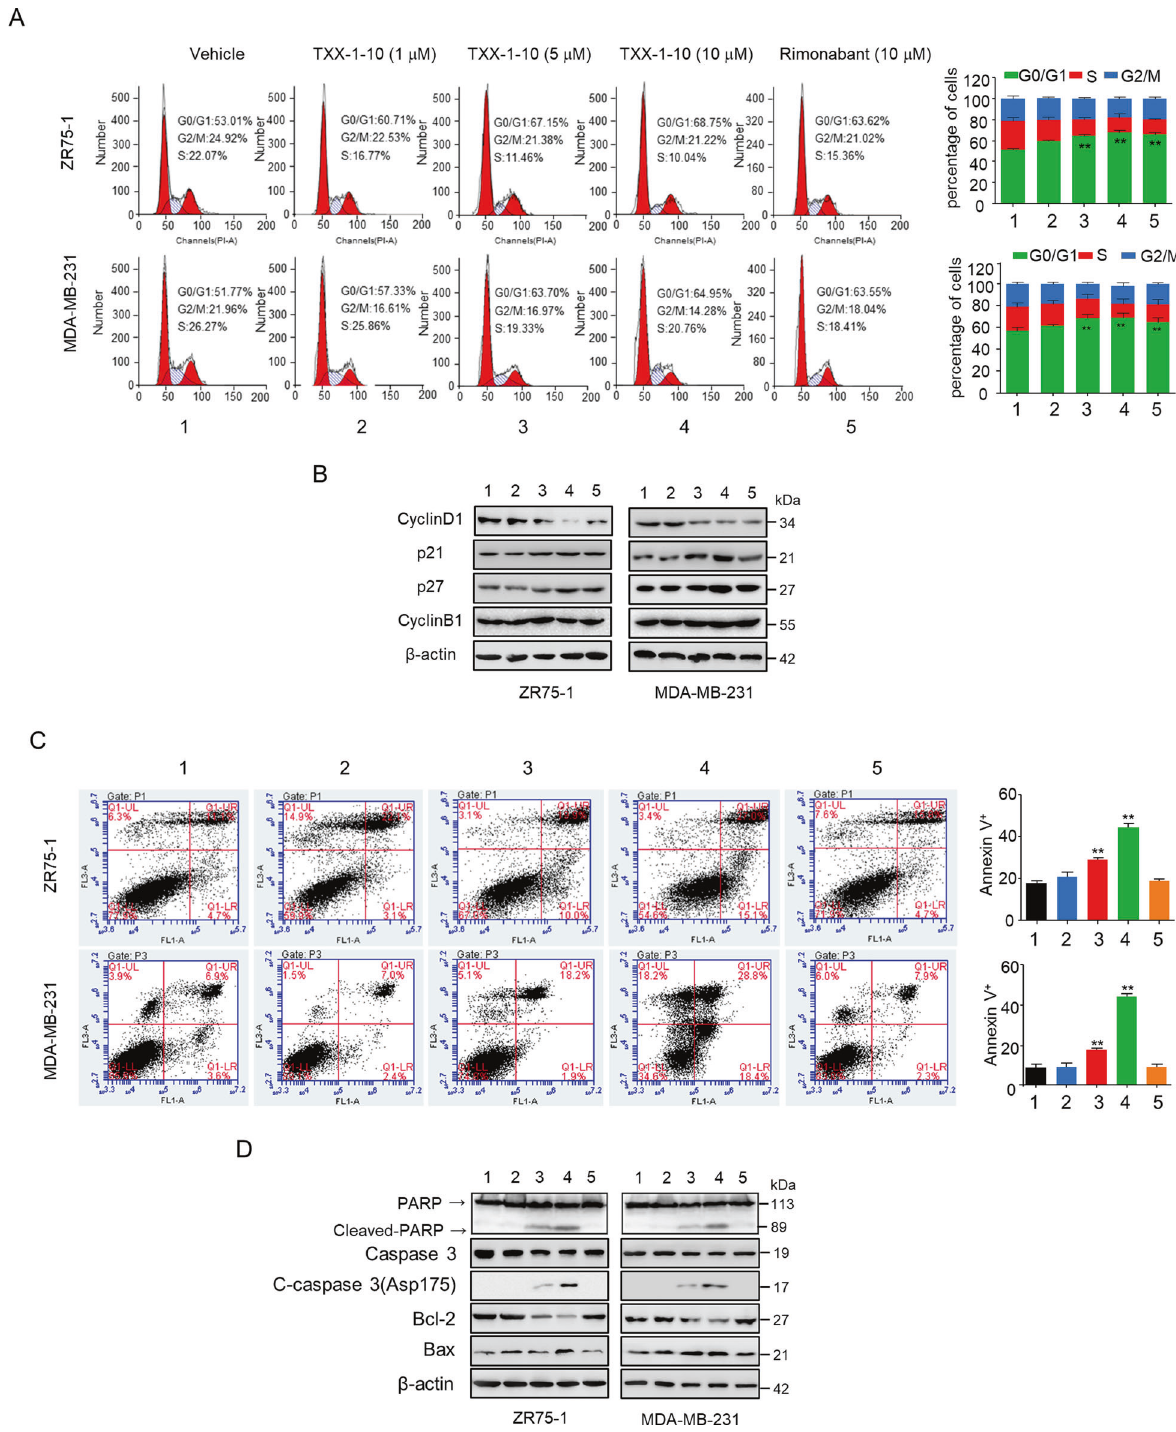
Fig. 3 TXX-1-10 induces G1/S cell cycle arrest and apoptosis in breast cancer cells. A The cell cycle distributions of ZR75-1 and MDA-MB-231 cells treated with TXX-1-10, Rimonabant, or vehicle for 48 h. The cell cycle was evaluated by fl ow cytometry after staining with propidium iodide (PI) for 30 min at 37 °C in dark. Histograms show the cell cycle distributions of ZR75-1 and MDA-MB-231 cells (right panel). B Representative immunoblot assay of ZR75-1 and MDA-MB-231 cells treated as in A with the indicated antibodies. C Representative images of fl ow cytometry analysis of apoptosis in ZR75-1 and MDA-MB-231 cells treated as in A . Statistical analysis of apoptosis rates was shown in the right panel. D Representative immunoblot assay of ZR75-1 and MDA-MB-231 cells from C with the indicated antibodies. Statistical signi fi cance was assessed by two-tailed Student ’ s t test. * p < 0.05, ** p < 0.01 versus the corresponding